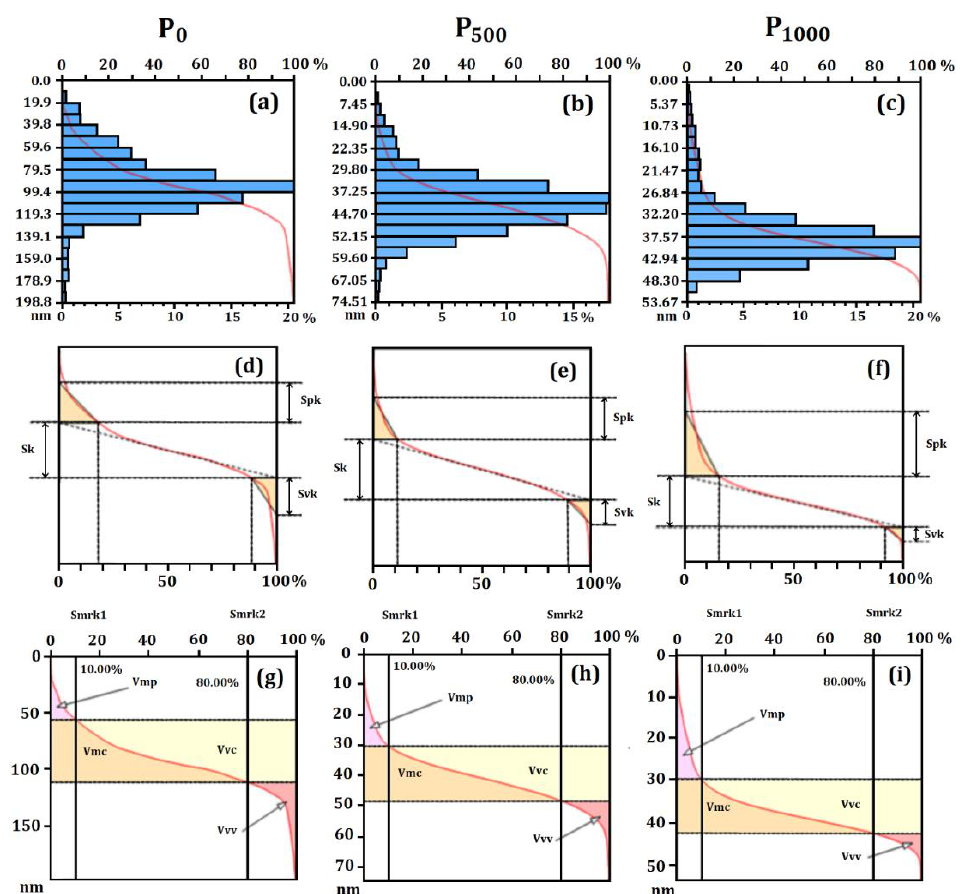
Figure 2. Sk values and volume parameters concerning the height distribution of the particle surface. ( a – c ) Particle surface of all systems (P 0 , P 500 , and P 1000 ) presenting a heavy-tailed distribution (Leptokurtic) with great tapering of the height distribution; ( d – f ) thickness of material on the particles surface, evaluated by the height distribution according to the Sk parameter family; ( e , f ) displacements of the Sk curve; and ( g – i ) graphic behaviors considering the volume parameters of the particles surface.